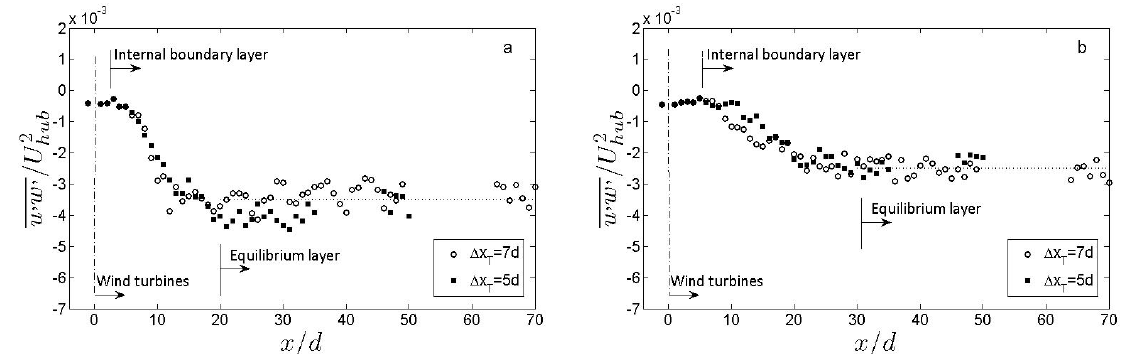
Figure 10. Non-dimensional distributions of kinematic shear stress ( top ) and turbulent kinetic energy production ( bottom ) inside and above a 10-turbines wind farm ( S